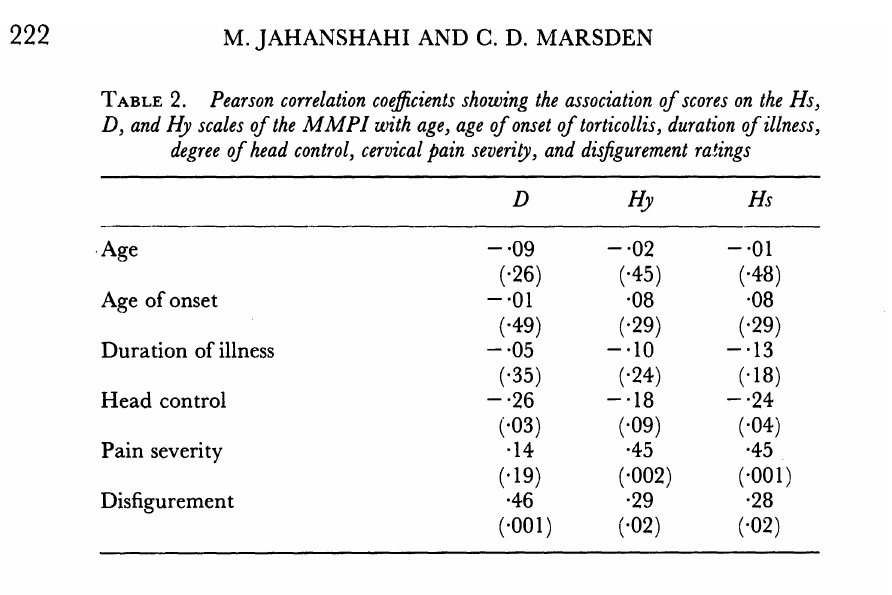
TABLE 2. Pearson correlation codficients showing the association of scores on the Hs, D, and Hy scales of the MMPI with age, age oj onset oj torticollis, duration of illness, degree of head control, cervical pain severiIY, and diifigurement ra.!ings D Hy Hs Age -·09